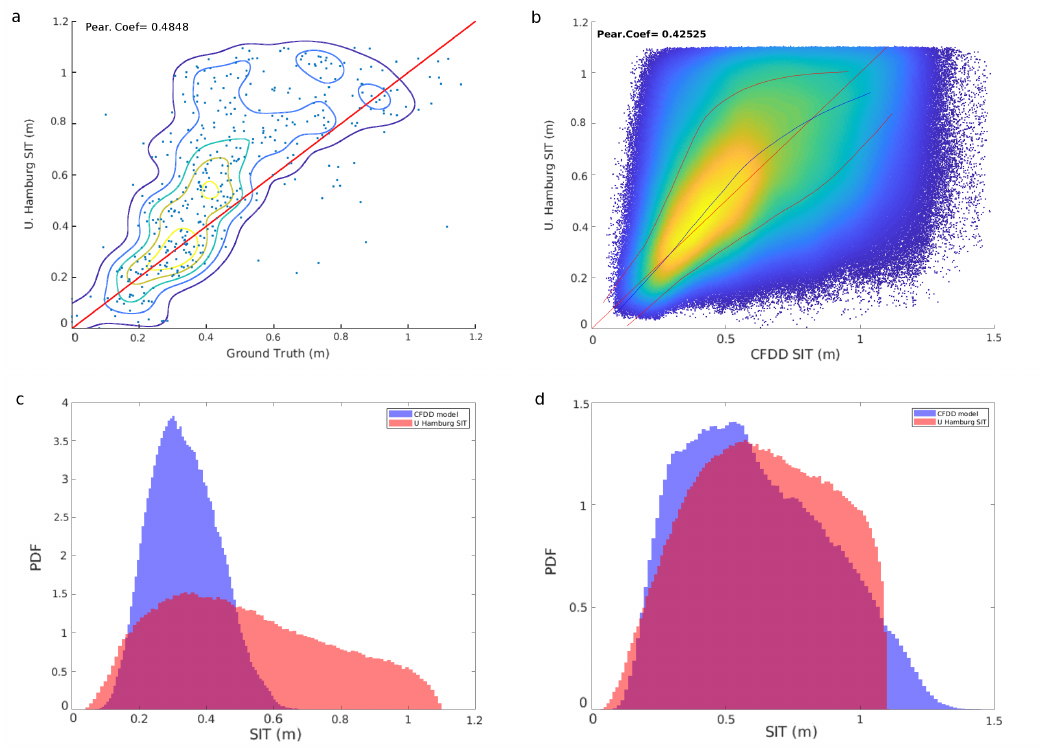
Figure 5. ( a ) Comparison between the ULS ground truth and the University of Hamburg (UH) ice thickness. Soil Moisture and Ocean Salinity (SMOS) thickness uncertainty and saturation ratio are always below 1 m and 90% respectively. The red line represents the identity line. Ground truth was acquired for the freeze-up periods between 2010 and 2017. ( b ) Comparison between the modeled CFDD SIT and UH ice thickness for the freeze-up periods between 2010 and 2017. SMOS thickness uncertainty and saturation ratio are always below 1 m and 90% respectively. The mean and standard deviations are depicted with a blue and red lines respectively. ( c ) Probability Density Functions (PDFs) of CFDD and UH SIT during October between the years 2010 and 2017. ( d ) PDFs of CFDD and UH SIT for case during the freeze-up periods between 2010 and 2017 with SIC over 90% in all